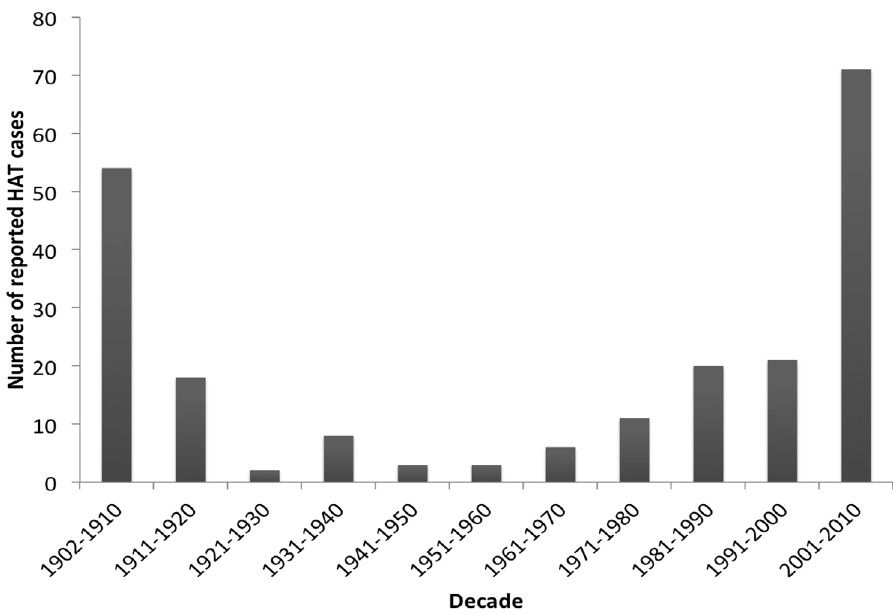
Figure 1. Number of reported HAT cases among patients from non-endemic countries per decade.